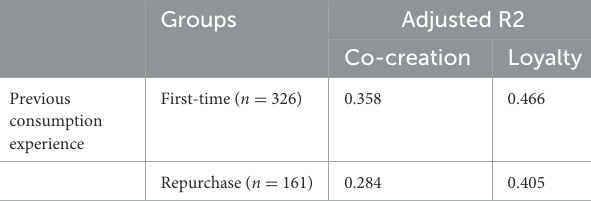
TABLE 5 Adjusted squared correlations of significantly different